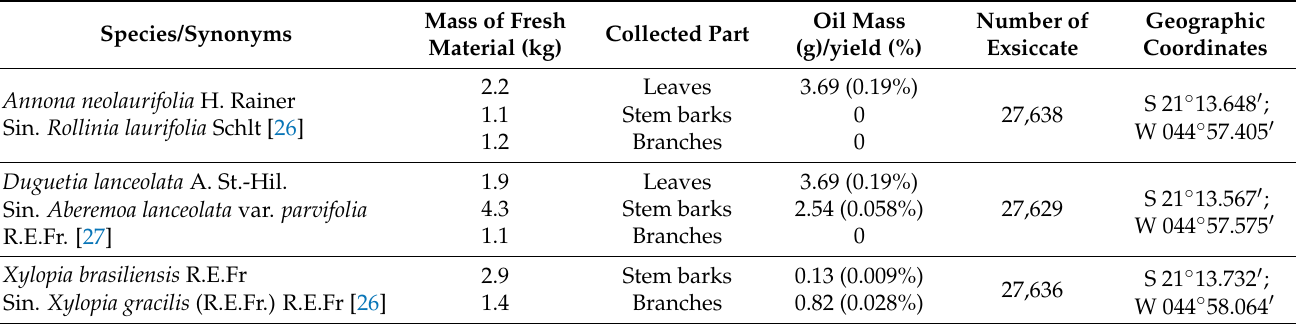
Table 1. Species of plants utilized to obtain essential